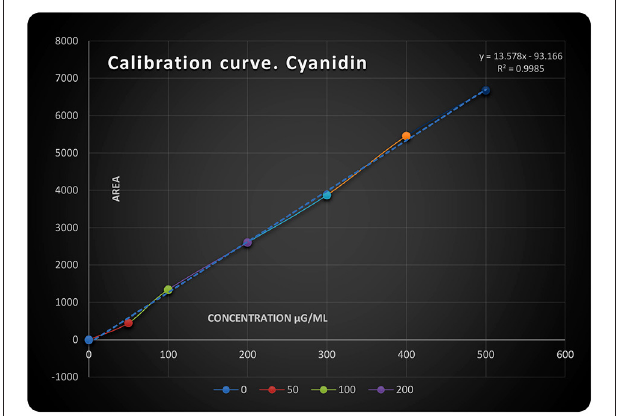
FIGURE 1 | Cyanidin chloride calibration